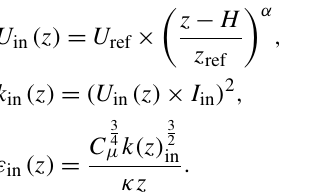
Figure 11. Normalized concentrations of CFD and experimental data at each measurement point in the 3D dispersion